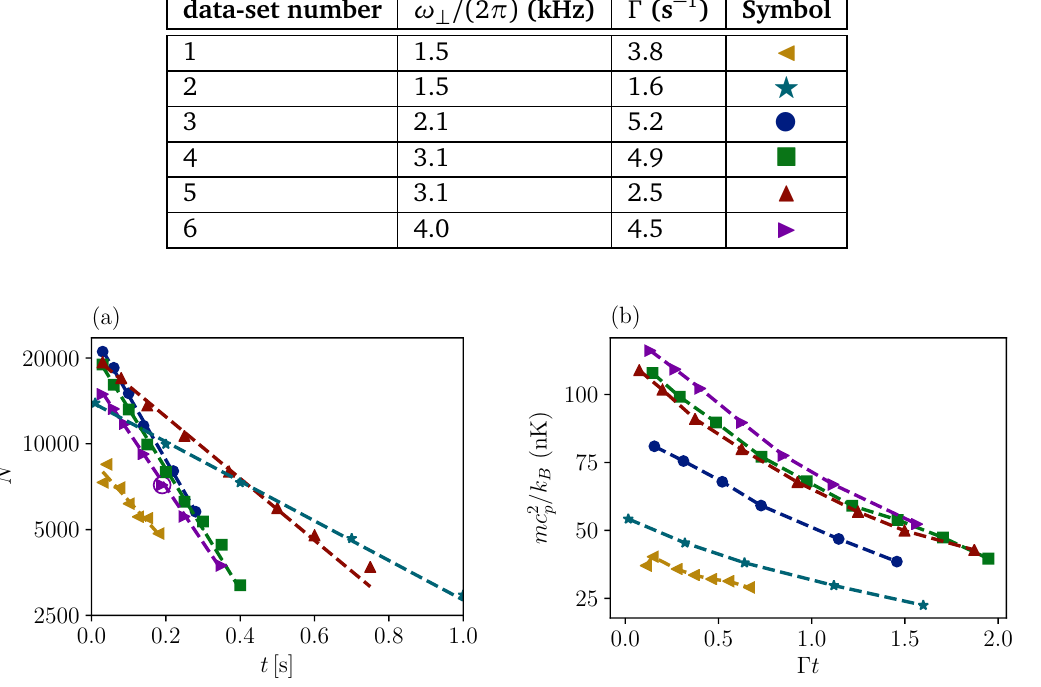
Figure 2: (a) Evolution of the total atom number for the different sets of data shown in semi-log scale. The loss rate Γ for each data set is deduced from an expontential fit, shown as dashed line. (b) Evolution of the energy scale mc 2 as a function of Γ t . Both plots use the color codes of table.